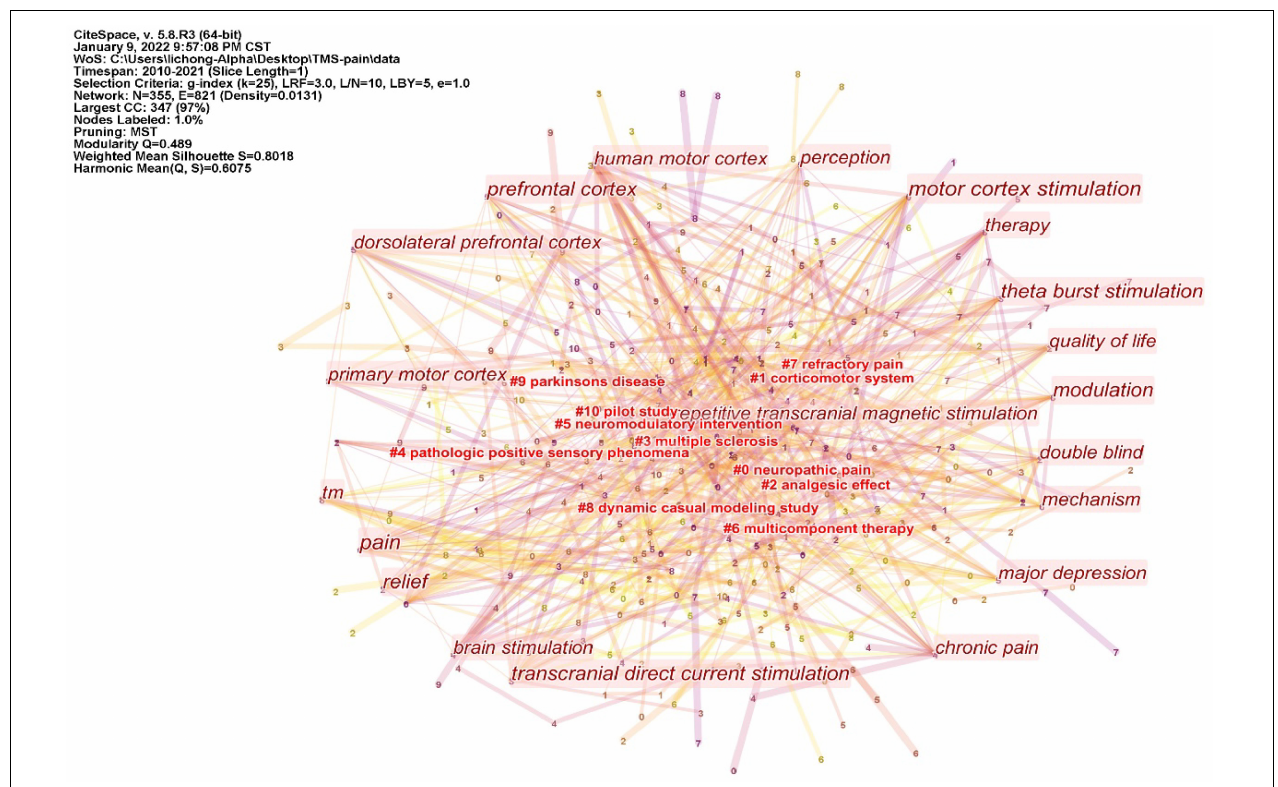
FIGURE 7 | Cluster of keywords from 440 inclusion studies. The keyword clusters (LLR algorithm) were divided into 11 categories (#0-10). Those without # are high-frequency keywords.